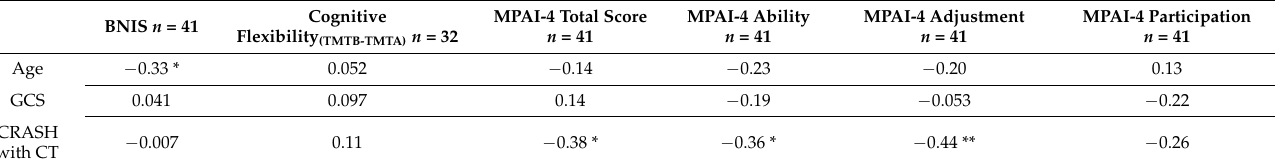
Table 2. Correlation for neuropsychological tests and MPAI-4 with age and injury-related variables.